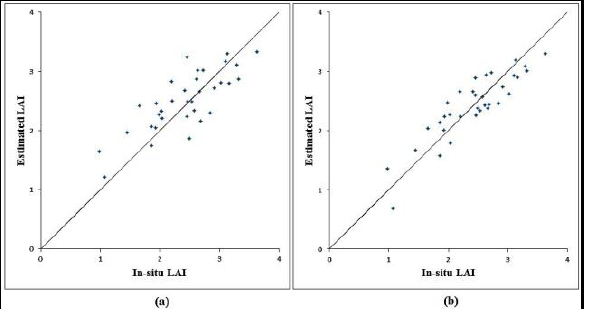
Figure 4. Scatter plot of in-situ LAI and estimated LAI (with 34 samples) using (a) backscattering coefficients and (b) even bounce, odd bounce and volume component derived using m-χ space decomposition; Line indicates the 1:1